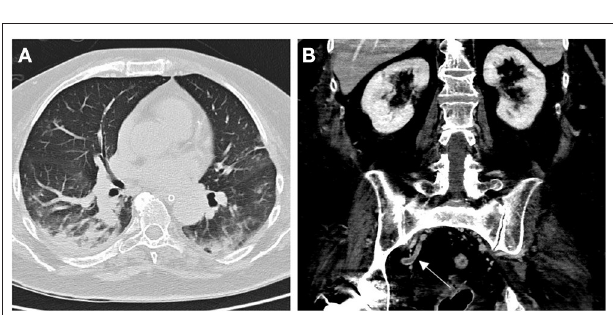
FIGURE 2 | Chest CT scan showing typical COVID-19 associated bilateral pneumonia ad admission (A) . Contrast-enhanced abdominal CT scan showing right internal vein thrombosis (arrow; B